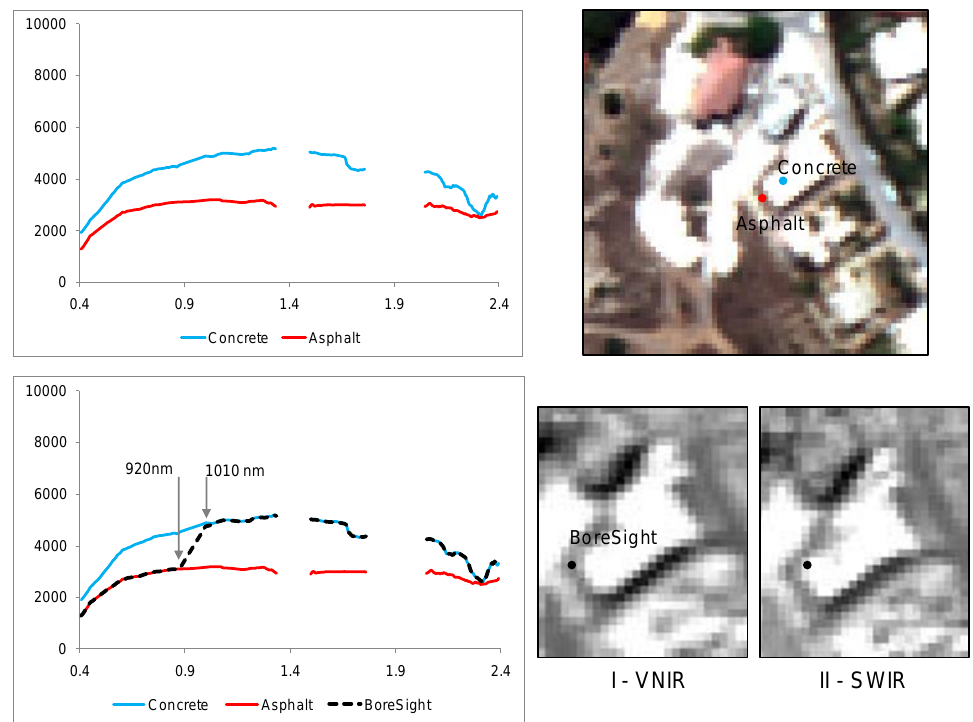
Figure 1. Schematic demonstration of the boresight effect. Images I-VNIR and II-SWIR illustrate the boresight: I is the target in the VNIR region and II is the target in the SWIR region, and the spectrum of the target (black dot) indicates that region I is pavement asphalt (spectrum in VNIR matches the asphalt (red) spectrum) and II is concrete roof (spectrum in SWIR matches the concrete (blue) spectrum).